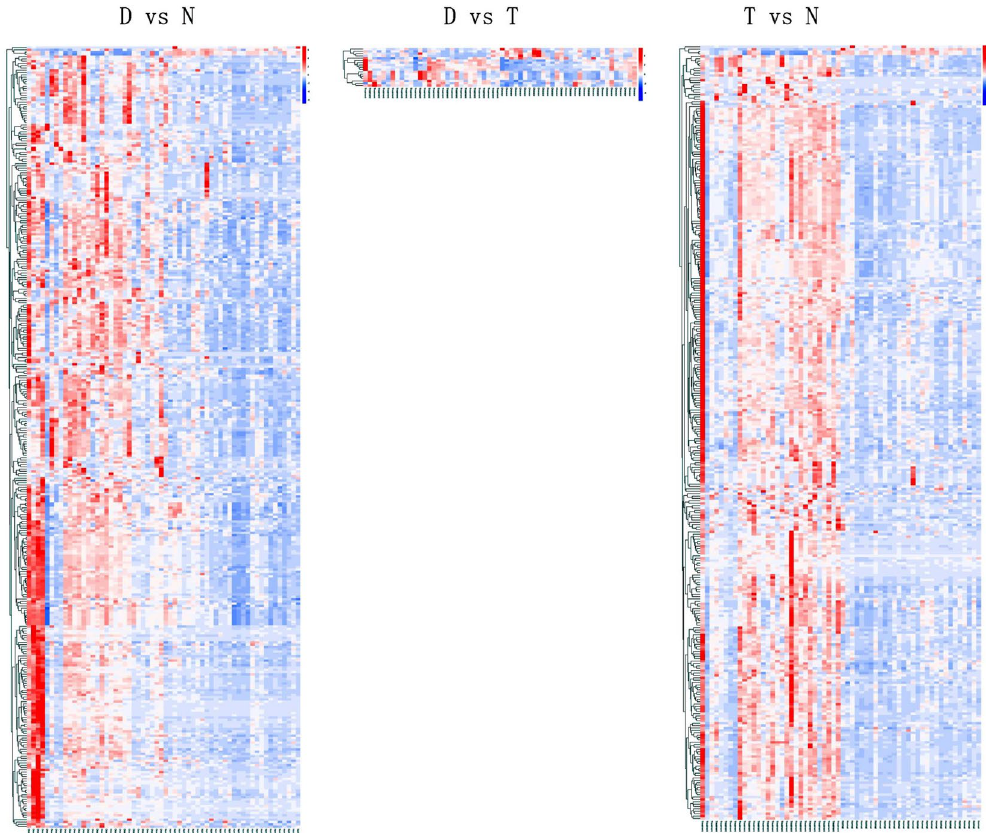
Figure 2. Heat map of hierarchical clustering analysis. The abscissa represents different experimental groups, the ordinate represents the differentially expressed metabolites by group, and the color blocks at different positions represent the relative expression of the corresponding metabolites. N: normal control group, D: varicocele group, T: varicocelectomy group. The Hierarchical clustering heatmap is generated by R(pheatmap) and the version is